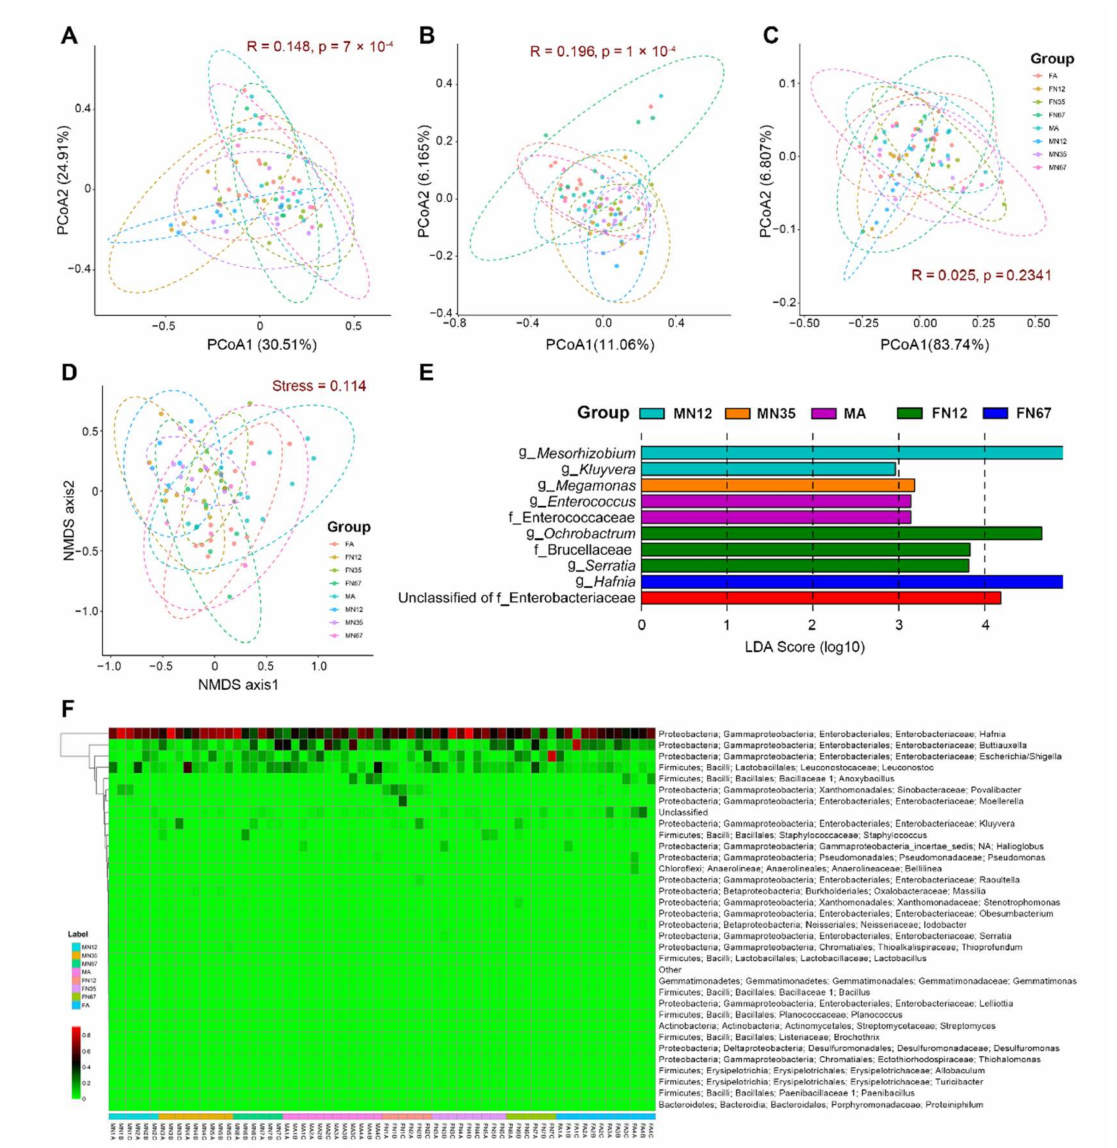
Figure 3. Bacterial beta diversity of Gampsocleis gratios . ( A – C ) Principal coordinate analysis (PCoA) based on Bray-Curtis dissimilarity indices, unweighted UniFrac, and weighted UniFrac distance. ( D ) Non-metric multidimensional scaling analysis (NMDS) based on Bray-Curtis dissimilarity indices. ( E ) Differences in bacterial taxa among groups determined by linear discriminative analysis effect size (LEfSe), Abbreviation: g_, genus and f_, family. ( F ) Heat map of the relative abundance of bacterial communities at the genus level. The genus of which abundance is less than 0.2% in all samples were classified into “Other”. The OTUs was not classified into genus level were marked by “Unclassified”. Heatmap color scale represents the proportion of sequences assigned to the